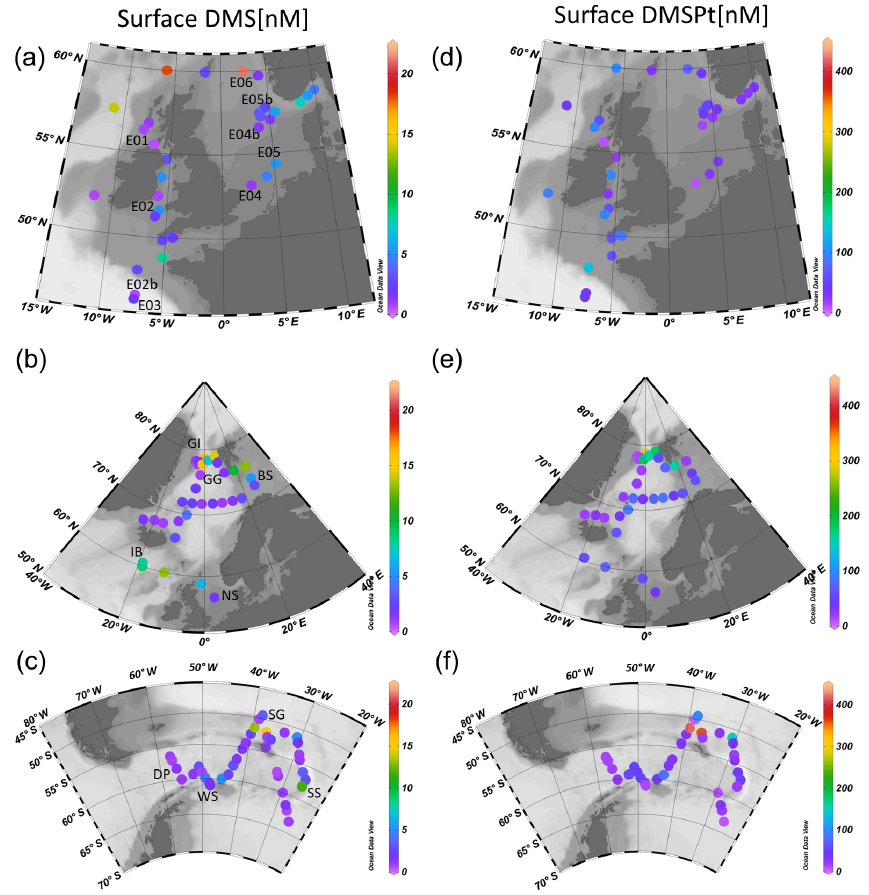
Figure 1. Surface ( < 5m) concentrations (nM) of DMS (a–c) and total DMSP (d–f) for cruises in the north-western European shelf (D366) (a, d) , the sub-Arctic and Arctic Ocean (JR271) (b, e) and the Southern Ocean (JR274) (c, f) . Locations of sampling stations for microcosm experiments shown in letters/numbers. E01–E05: see Hopkins and Archer (2014). NS: North Sea , IB: Iceland Basin , GI: Greenland Ice-edge